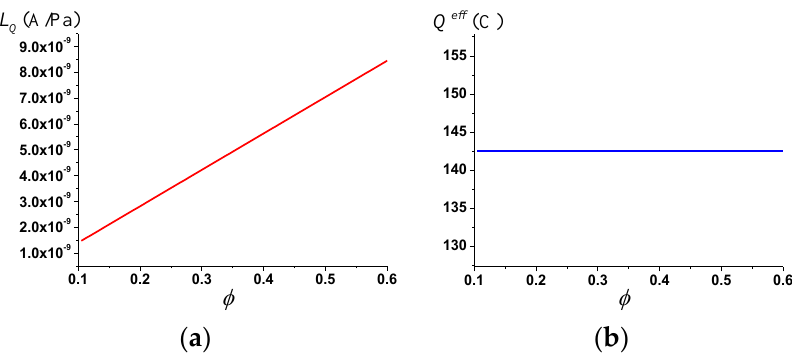
Figure 8. Effect of porosity (time-harmonic case): ( a ) streaming current coupling coefficient; ( b ) ef- fective net residual charge density. effective net residual charge density.